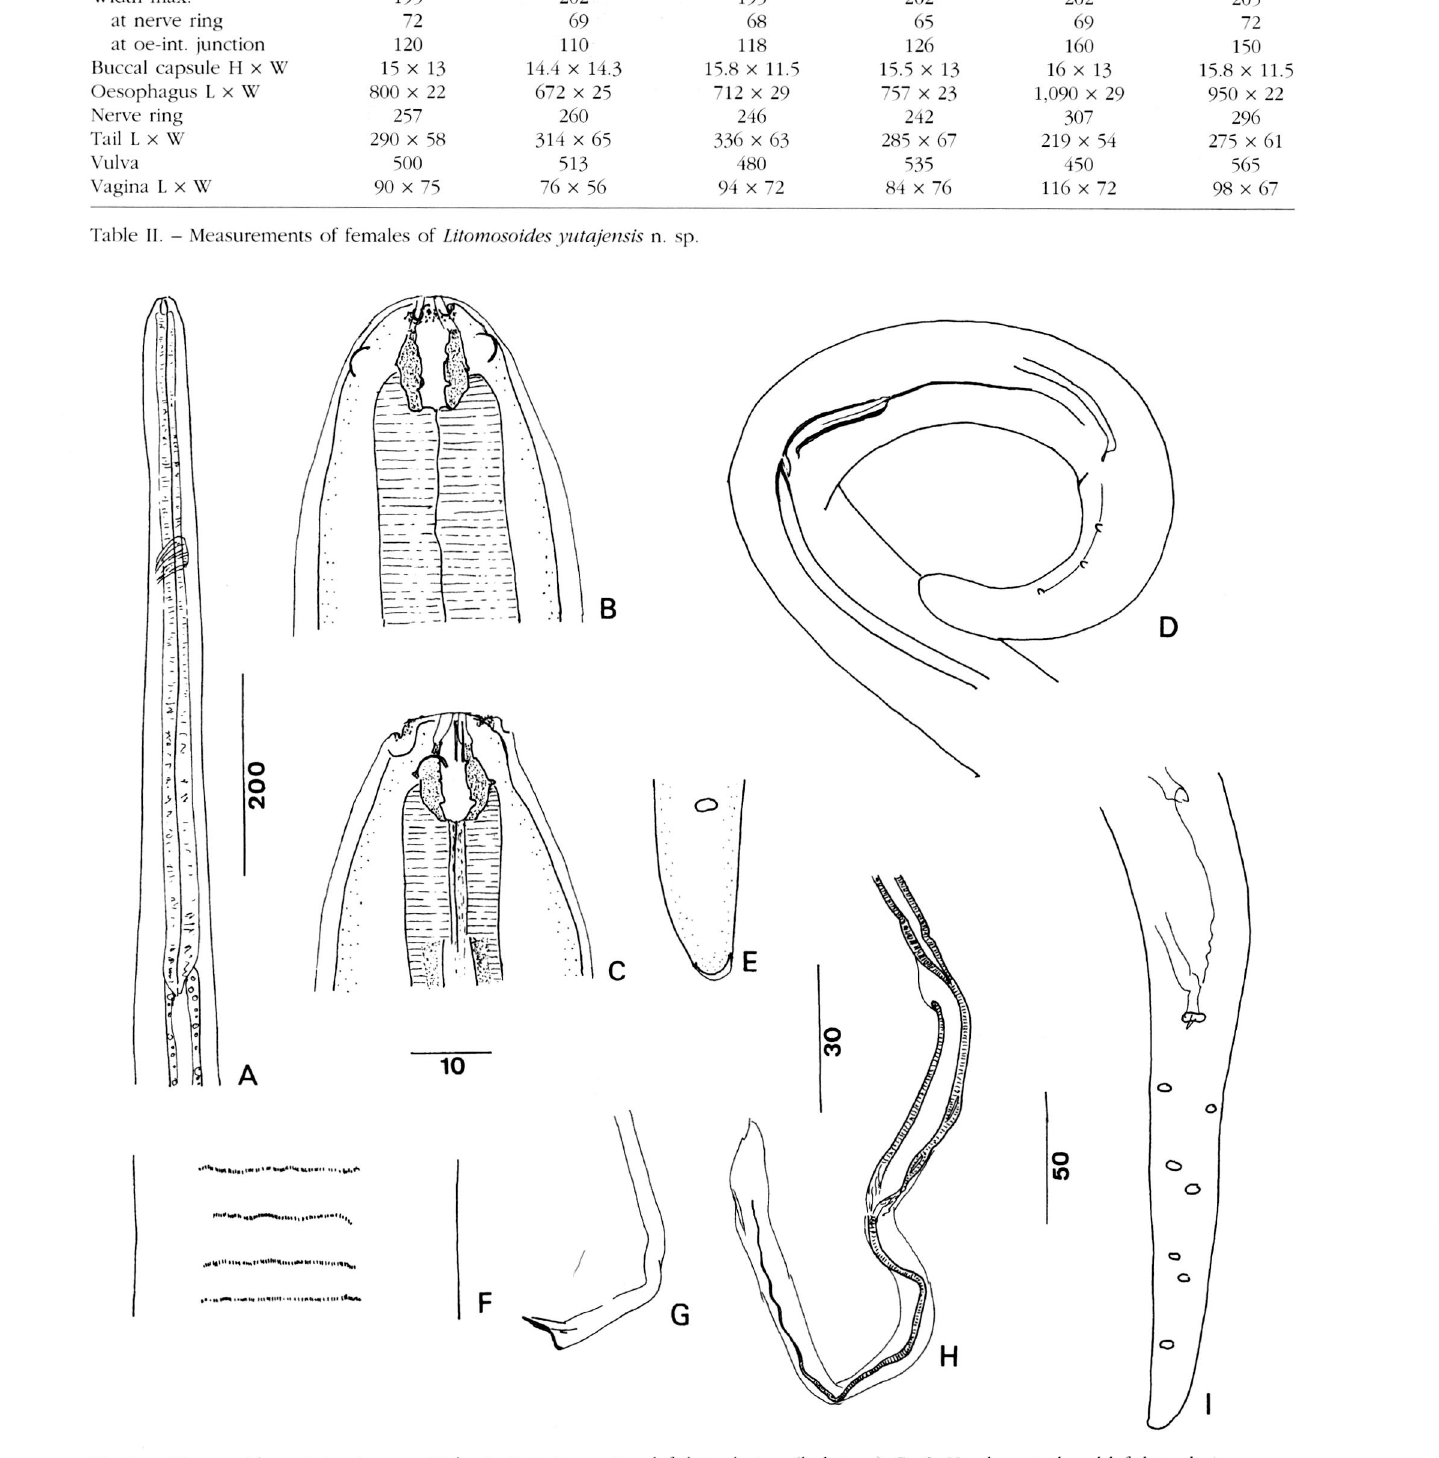
Table II. - Measurements of females of Litomosoides yutajensis n. sp.